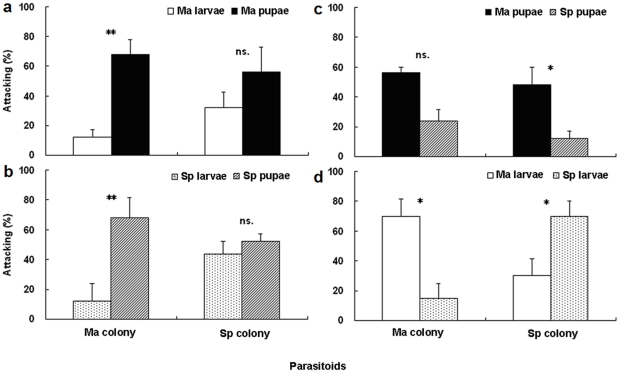
Feeding preference of Sclerodermus harmandi from different culturing systems on two development stages of hosts: (1a) pupae vs. larvae of Ma, (1b) pupae vs. larvae of Sp, (1c) pupae of Ma vs. Sp, and (1d) larvae of Ma vs. Sp.Abbreviations used: Ma, Monochamus alternatus; Sp, Saperda populnea; Ma larvae, Ma pupae, larvae and pupae of M. alternatus, respectively; Sp larvae, Sp pupae, larvae and pupae of S. populnea, respectively (Mean±SE, n = 25 females in each treatment, ** P<0.01, * P<0.05 and ns. P>0.05).